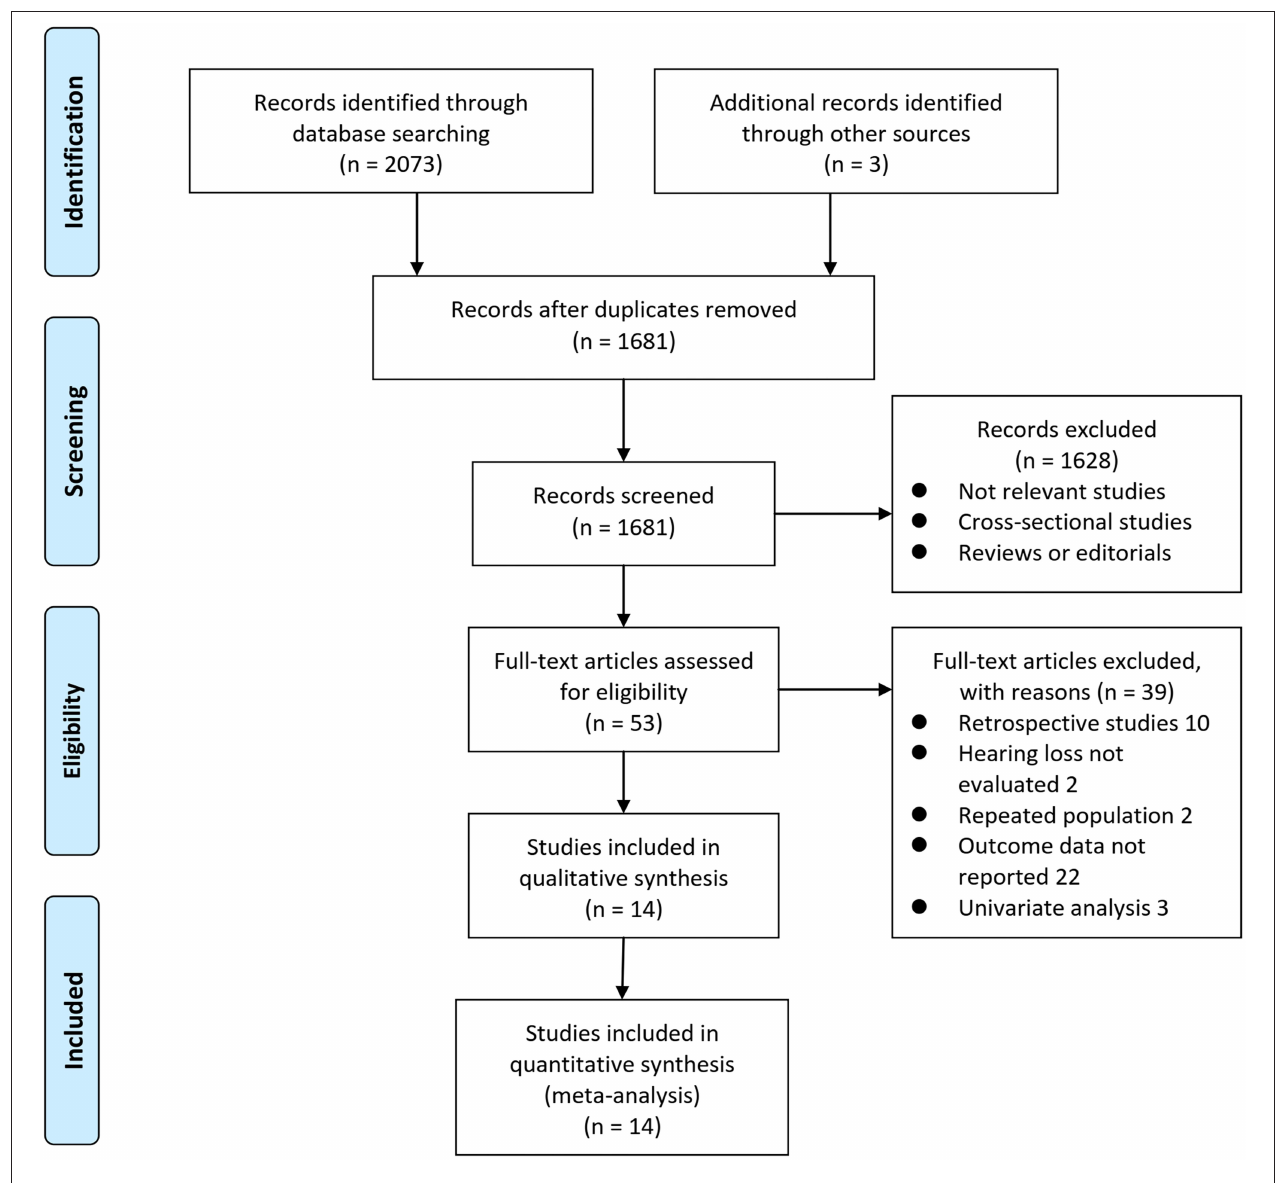
FIGURE 1 | Scheme of study inclusion following